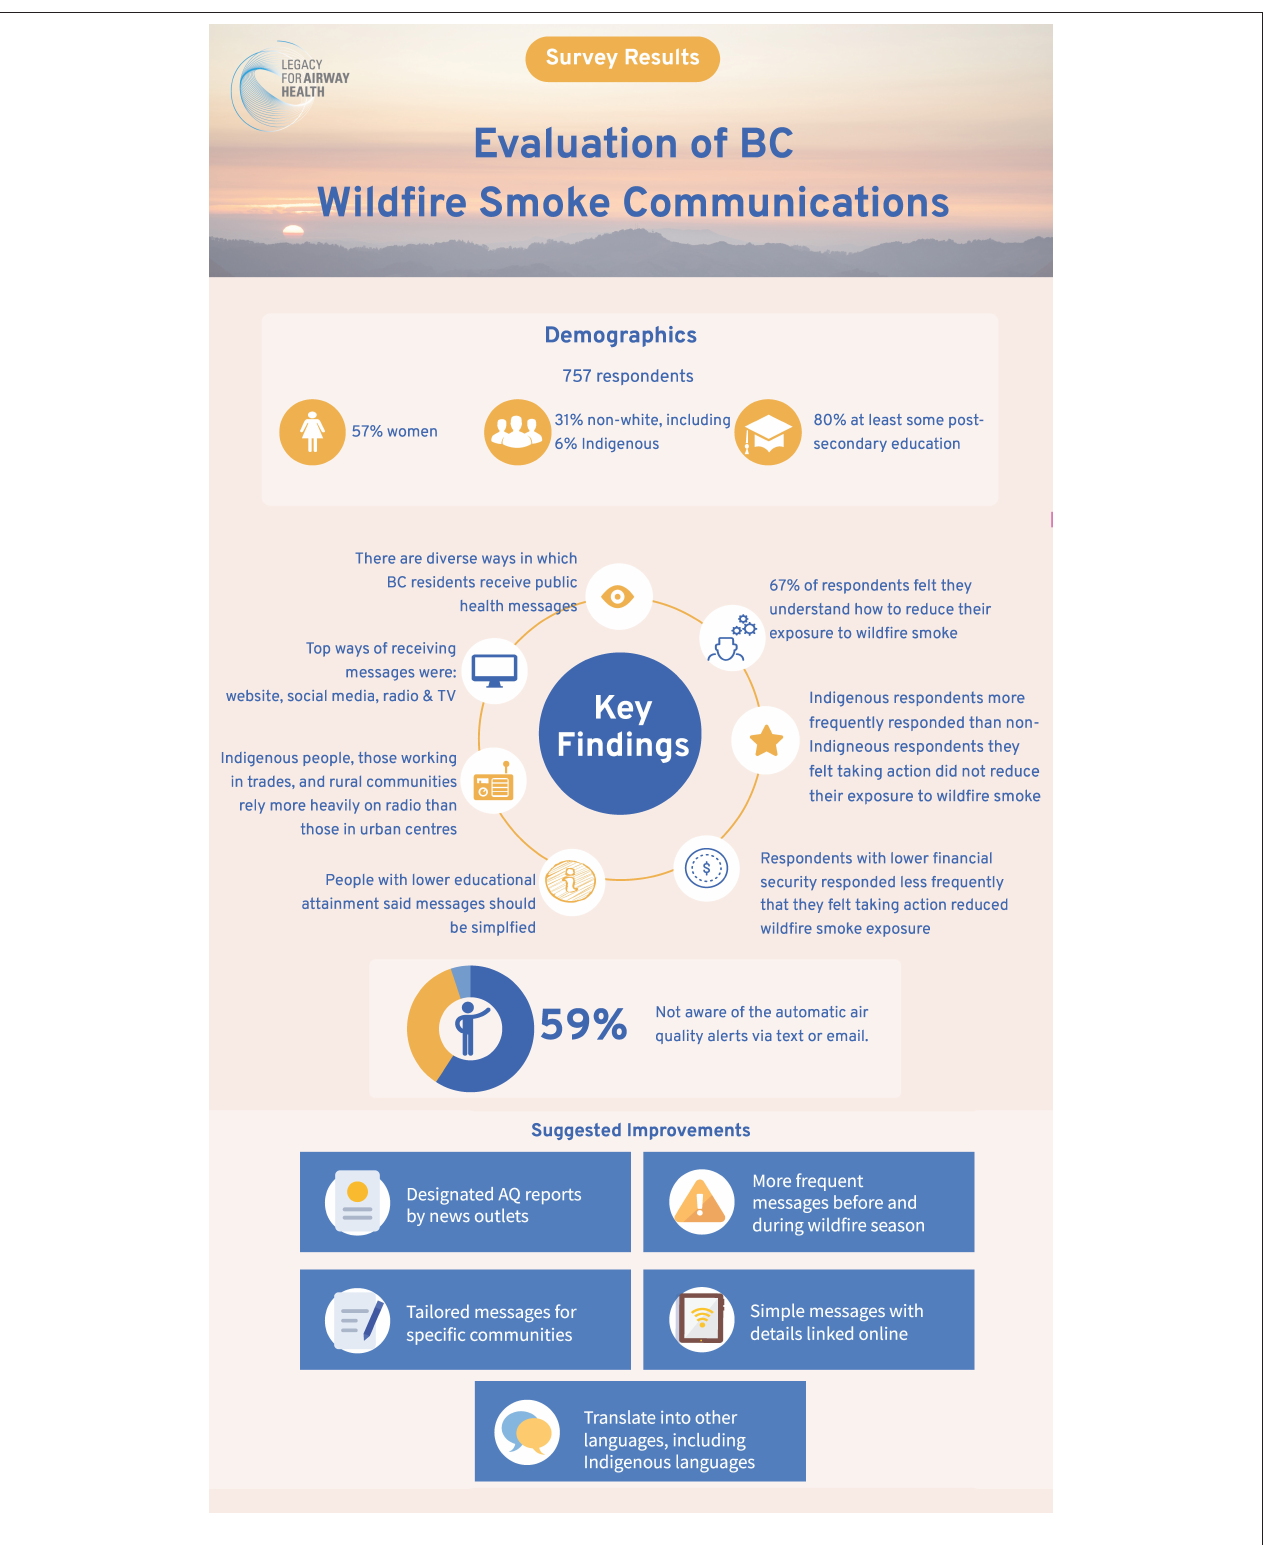
FIGURE 2 | Summary of survey results of wildfire smoke communications in British Columbia.